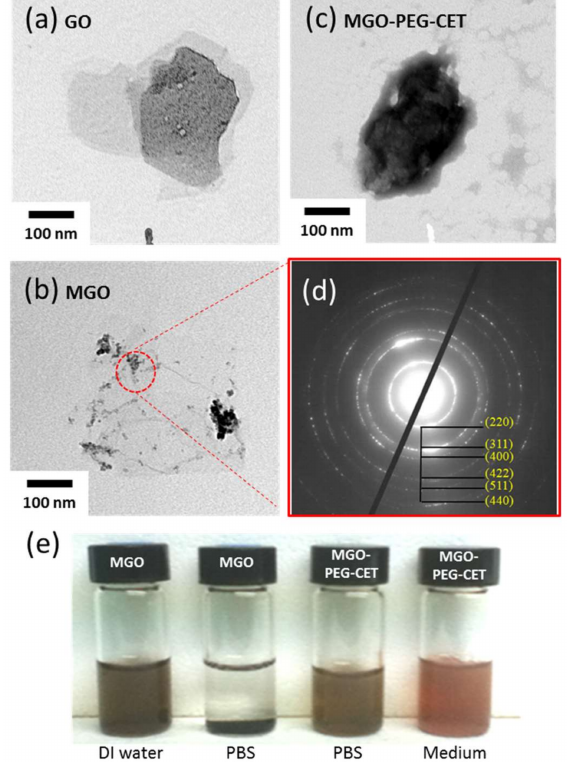
Figure 2. Transmission electron images of graphene oxide (GO) ( a ); MGO ( b ); and, MGO-PEG-CET after staining with 2% phosphotungstic acid ( c ); ( d ) The selected area electron diffraction patterns of MGO in the circled area in ( b ); ( e ) The suspension stability of 0.1 mg/mL MGO and MGO-PEG-CET in deionized (DI) water, phosphate buffered saline (PBS) and cell culture medium after 24